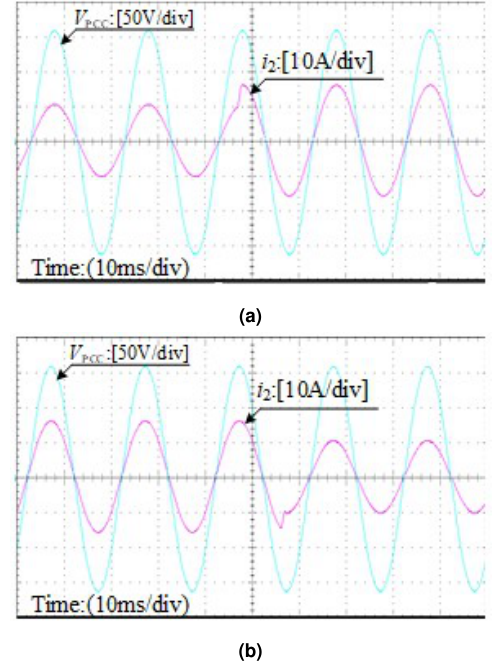
Fig. 20. Dynamic experimental waveform of improved WAC control method. (a) The reference current amplitude jumps from 10A to 16A. (b) The reference current amplitude jumps from 16A to